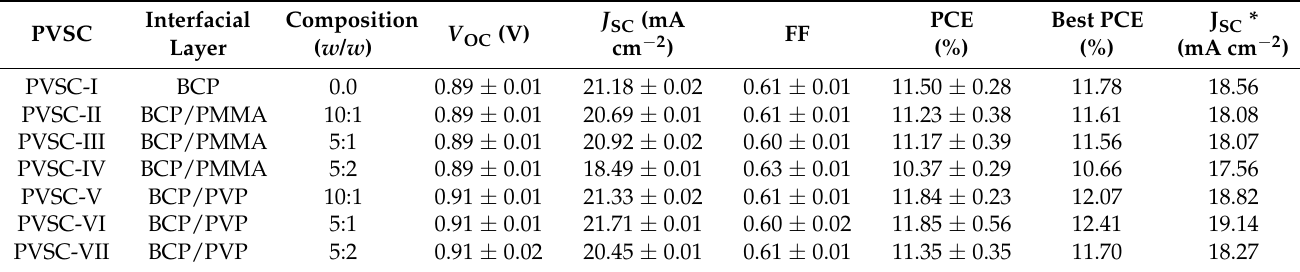
Table 1. PV properties of PVSCs incorporating BCP, BCP/PMMA, and BCP/PVP films.